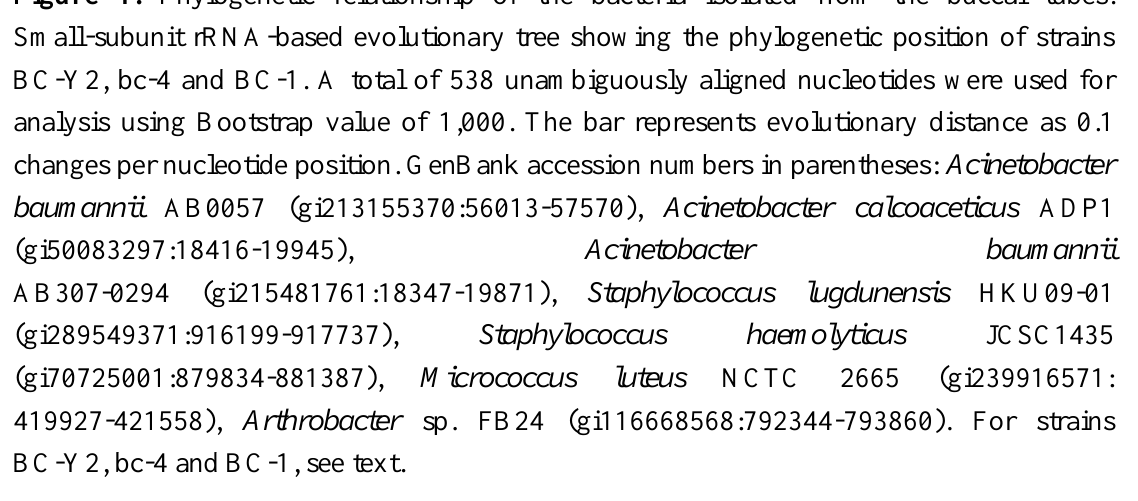
Figure 1. Phylogenetic relationship of the bacteria isolated from the buccal tubes. Small-subunit rRNA-based evolutionary tree showing the phylogenetic position of strains BC-Y2, bc-4 and BC-1. A total of 538 unambiguously aligned nucleotides were used for analysis using Bootstrap value of 1,000. The bar represents evolutionary distance as